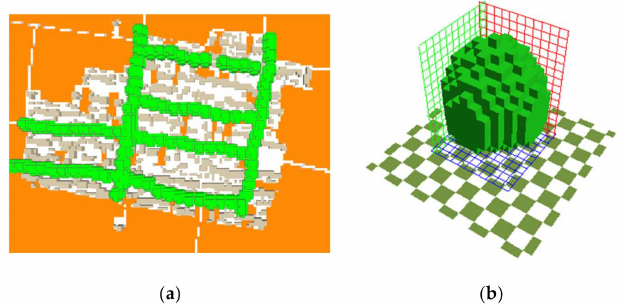
Figure 4. The three-dimensional model with street trees. ( a ) Platanus trees with a distance of 15 m. ( b ) A model of Platanus